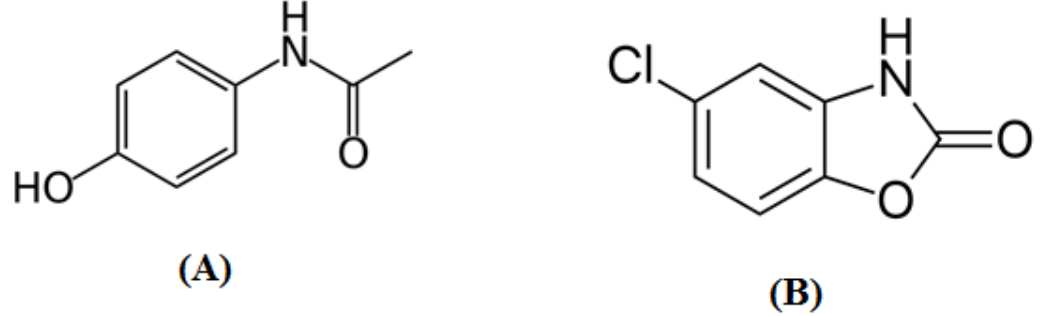
Figure 1. Molecular structures of ( A ) paracetamol (PCT) and ( B ) chlorzoxazone (CZN).